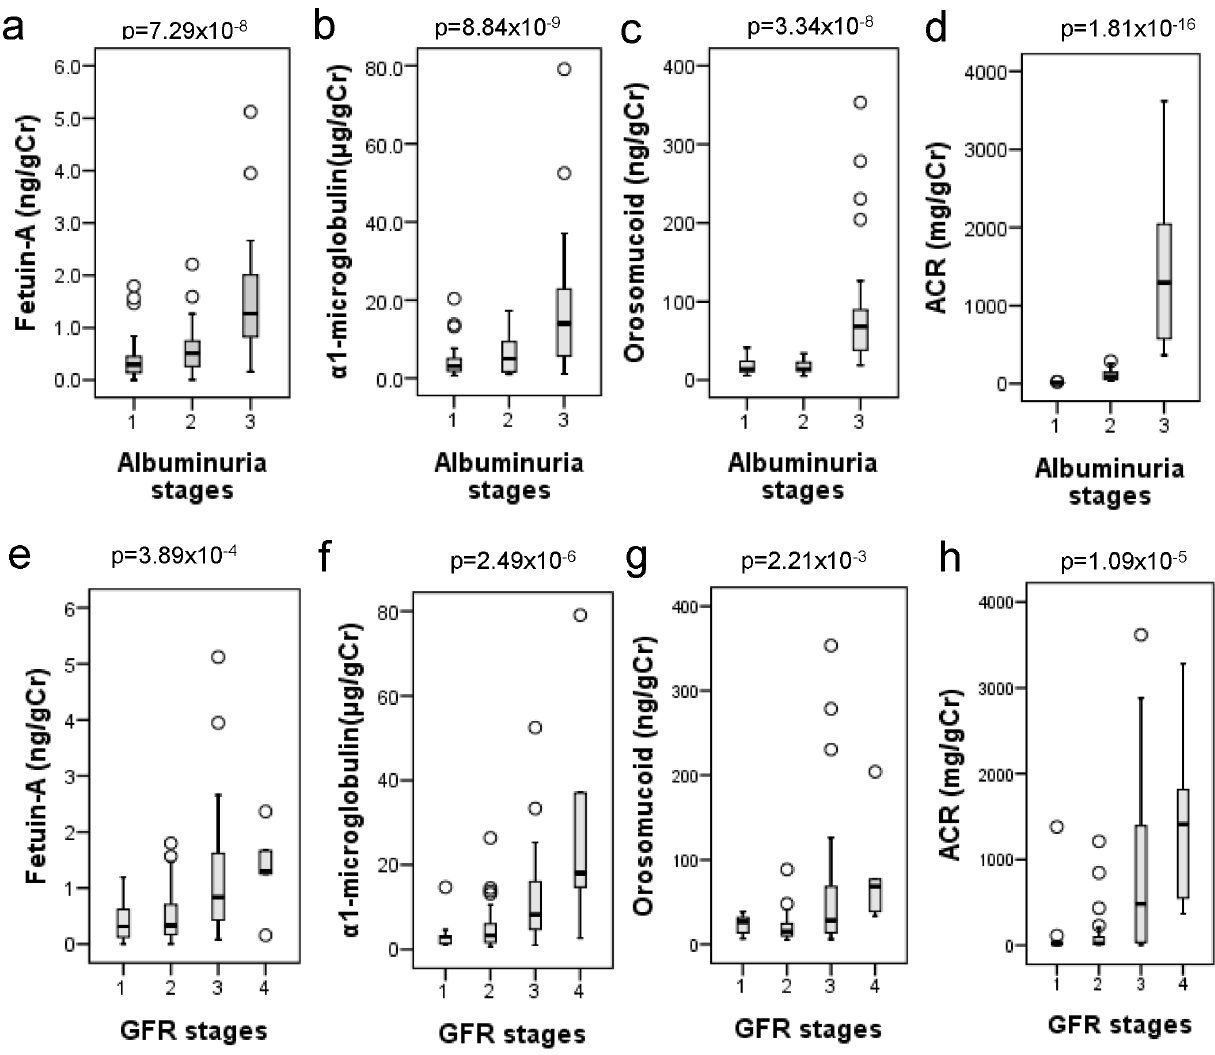
Figure 3. Urinary excretion of fetuin-A, a 1-microglobulin, orosomucoid and albumin creatinine ratio (ACR) in various stages of diabetic nephropathy (n=85). All of the urinary excretion of sialylated glycoprpteins such as fetuin-A, a 1-microglobulin, and orosomucoid are compared by Kruskal-Wallis test.